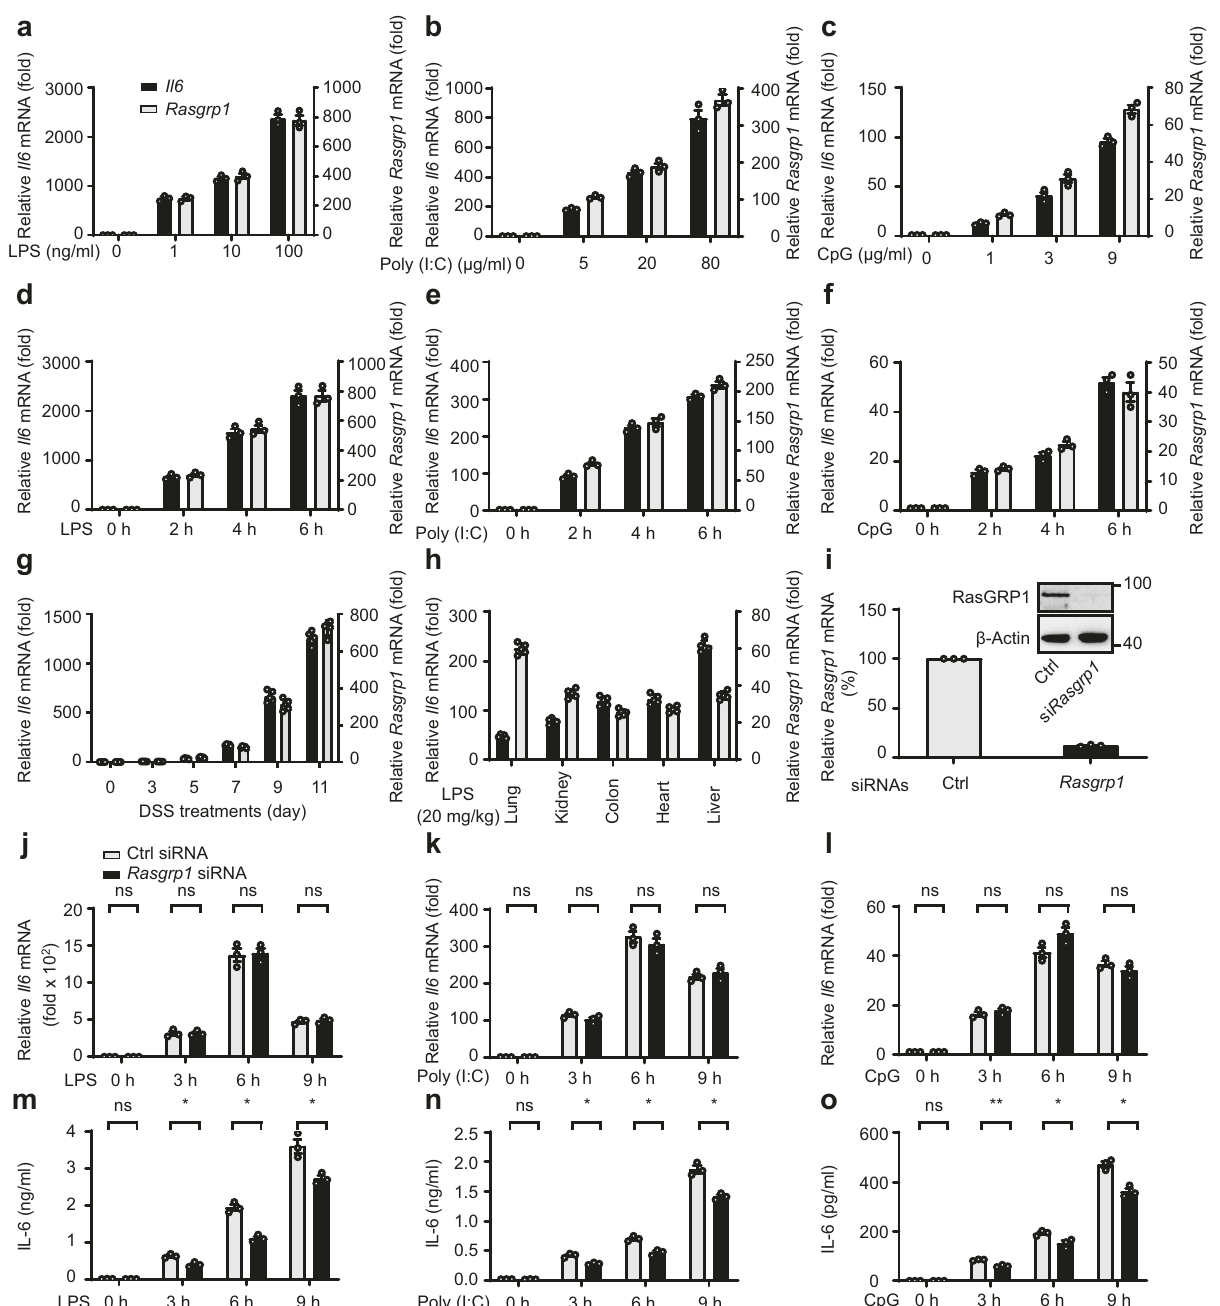
Fig. 2 | Rasgrp1 is coexpressed with Il6 , and Rasgrp1 silencing selectively inhi- bits IL-6 protein expression in an acute in fl ammatory response. a – c Quantitative PCR (Q-PCR) analysis of Il6 and Rasgrp1 mRNA expression in peri- tonealmacrophagestreatedwithdifferentdosesoflipopolysaccharide(LPS;0,1,10 or100ng/ml)( a ),polyinosinic-polycytidylicacid(poly(I:C);0,5,20or80 μ g/ml)( b ), or CpG oligodeoxynucleotide (0, 1, 3 or 9 μ g/ml) ( c ) for 6h. d – f qPCR analysis of Il6 and Rasgrp1 mRNA expression in peritoneal macrophages treated with 100ng/ml LPS ( d ), 10 μ g/ml poly (I:C) ( e ), or 5 μ g/ml CpG ODN ( f ) for the indicated times (hours). g qPCR analysis of Il6 and Rasgrp1 mRNA expression in intestinal epithelial cells isolated from dextran sulphate sodium (DSS)-treated mice on the indicated days. h qPCR analysis of Il6 and Rasgrp1 mRNA expression in organs from mice